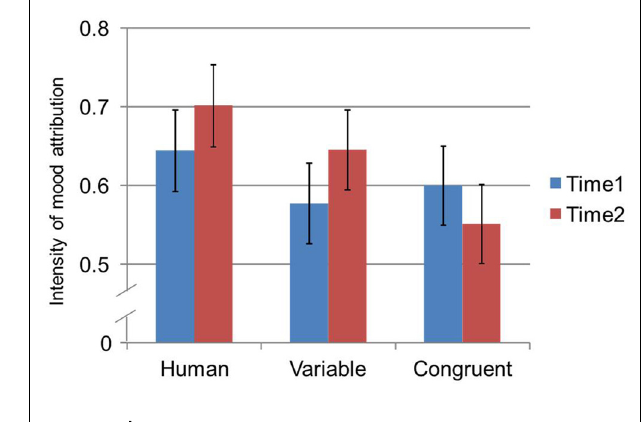
FIGURE 6 |Two-way interaction between measurement time and gaze on intensity of emotional attributions measured by the